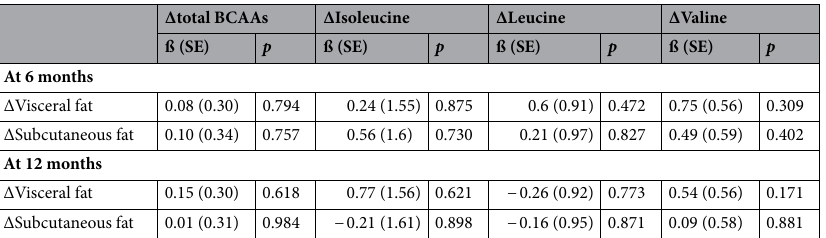
Table 5. Changes(Δ) in adiposity measures at 6 months and 12 months per unit change in BCAAs at 6 months. ß (SE) represents changes of the outcomes per change in the circulating metabolite levels during the exercise intervention. Data after adjustment for age, sex, total energy intake, protein intake, intervention group, BMI, value for the respective outcome traits at the baseline examination, total BCAAs, isoleucine, and valine at baseline, ΔHOMA-IR, and ΔBMI. Abbreviations: HOMA-IR , homeostatic model assessment of insulin resistance; BMI body mass index. ΔHOMA-IR and ΔBMI: changes in HOMA-IR and BMI from baseline to 6 months.